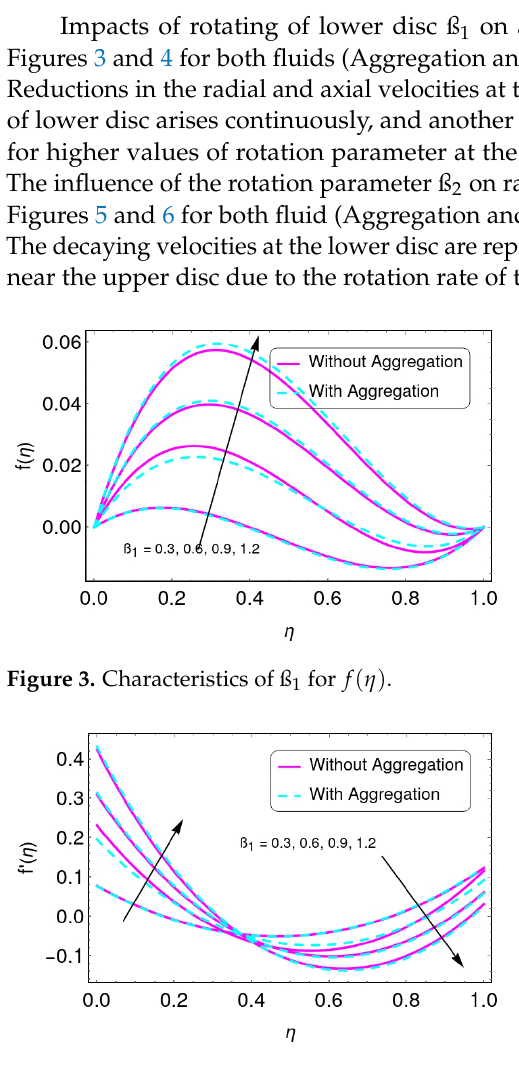
Figure 4. The result of ß 1 on f ( η )